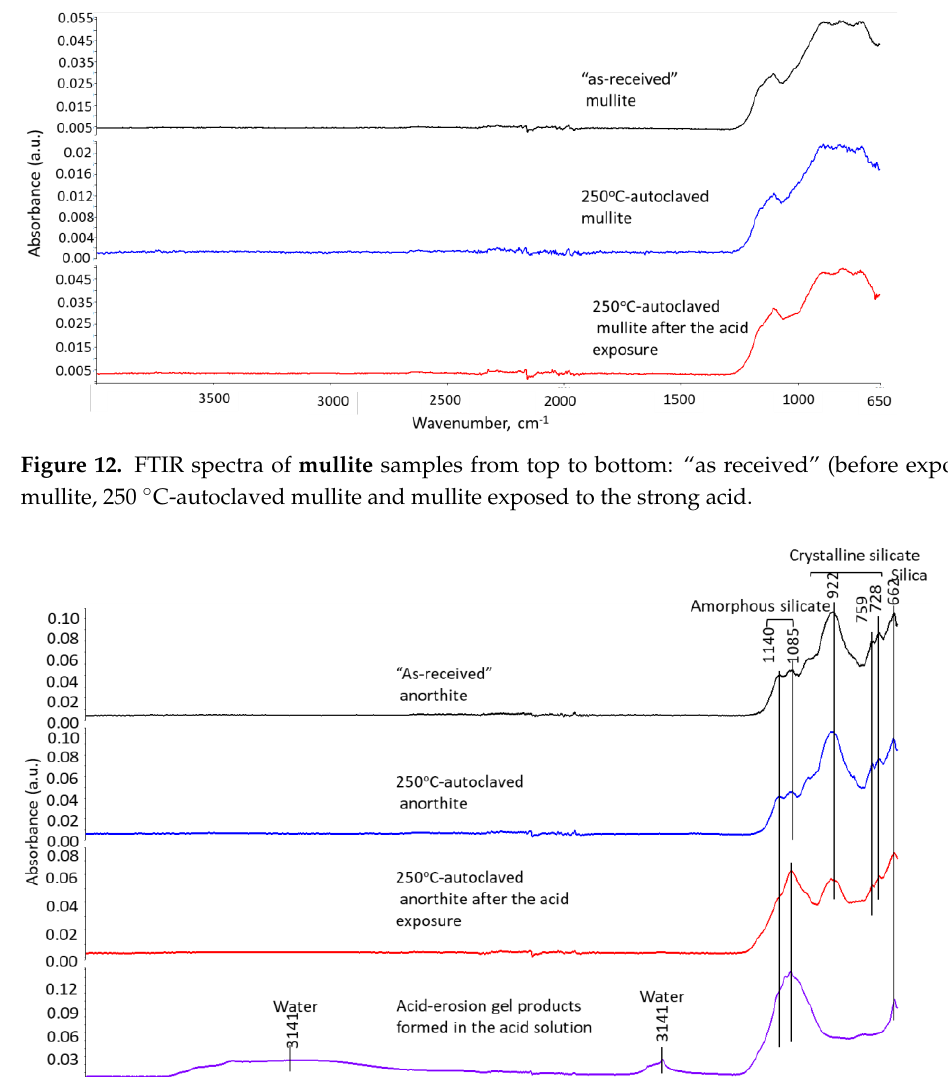
Figure 14. FTIR spectra of aluminum oxide samples from top to bottom: “as received” (before exposure) aluminum oxide, 250 °C-autoclaved aluminum oxide and aluminum oxide exposed to the strong acid.